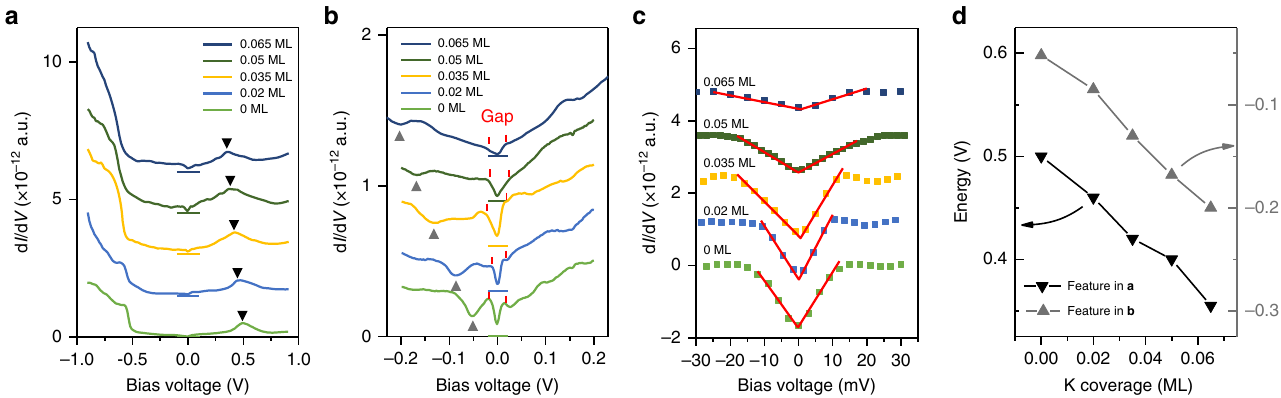
Fig. 4 d I /d V spectra taken on the 1 T ’ -WTe 2 surface with different potassium (K) coverage. a , b d I /d V spectra taken in a large and small energy scales. U = + 500 mV for a and U = + 200 mV for b , I = 200 pA. The black colored triangles in a and gray colored triangles in b mark the characteristic features in the t d I /d V spectra, which move towards the left upon K deposition and are used to determine the shift of Fermi energy. The gap region is marked by the red vertical lines in b . c The Zoom-in spectra of b showing the DOS near the Fermi energy. The suppression of the DOS at the Fermi level is always distinguishable. The background is subtracted, and the DOS is fi tted with a linear function near the Fermi energy. d The position of the characteristic features as marked in a and b as a function of K